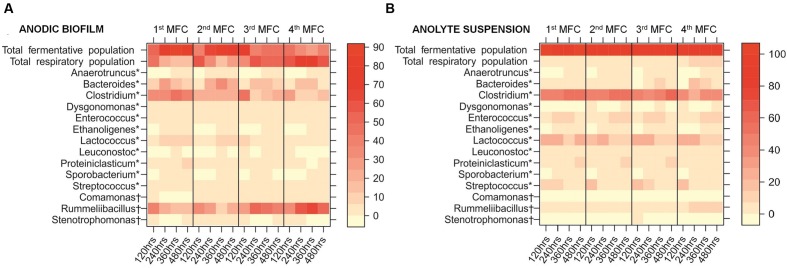
Heatmap showing the percentage abundance of the 14 most abundant genera within: (A) the anodic biofilm of each MFC in the cascade; (B) the anolyte suspension of each MFC in the cascade. Results shown are average percentage abundance of three biological replicates. Total fermentative population represents the total number of fermentative species out of the top 14 most abundant genera. Total respiratory population represents the total number of anaerobic respiratory species out of the top 14 most abundant genera. ∗Fermentative metabolism most likely, †Anaerobic respiration most likely.